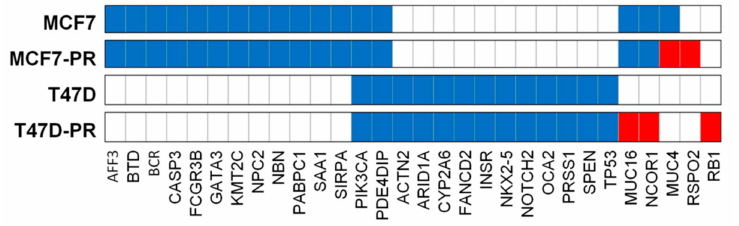
Figure 4. Mutation dot plot of 30 genes with 52 of the most clinically significant mutations. We selected mutations with only High impact or pathogenic mutations in ClinVar for the mutation dot plot. Mutations of the parent cells that remained in the resistant cells are colored blue, while newly exhibited mutations in the resistant cells are colored red. The bar graph represents the number of mutations in each cell. T47D-PR cells obtained the following new mutations: MUC16 (K13558fs) , NCOR1 (R190*), and RB1 (Y659fs). Meanwhile, MCF7-PR cells exhibited the following new mutations: MUC4 (M3855fs, L3857fs, T3860fs, P3862fs) and RSPO2